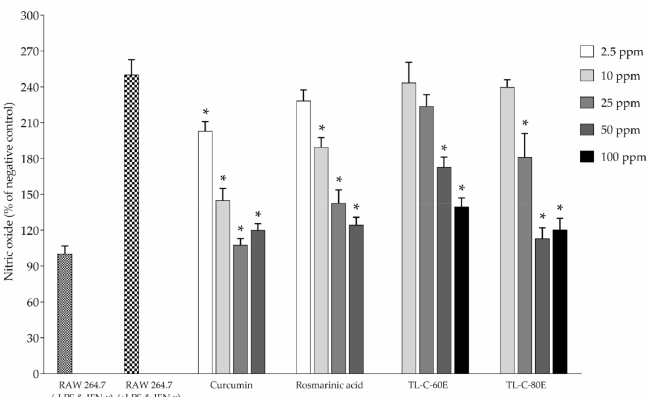
Figure 3. Inhibition effect of SRAEE on nitric oxide production. Data represents the mean ± SD of three independent experiments. * Indicate a significant difference of experimental samples versus treated cells with combined LPS and IFN- γ induction ( p <